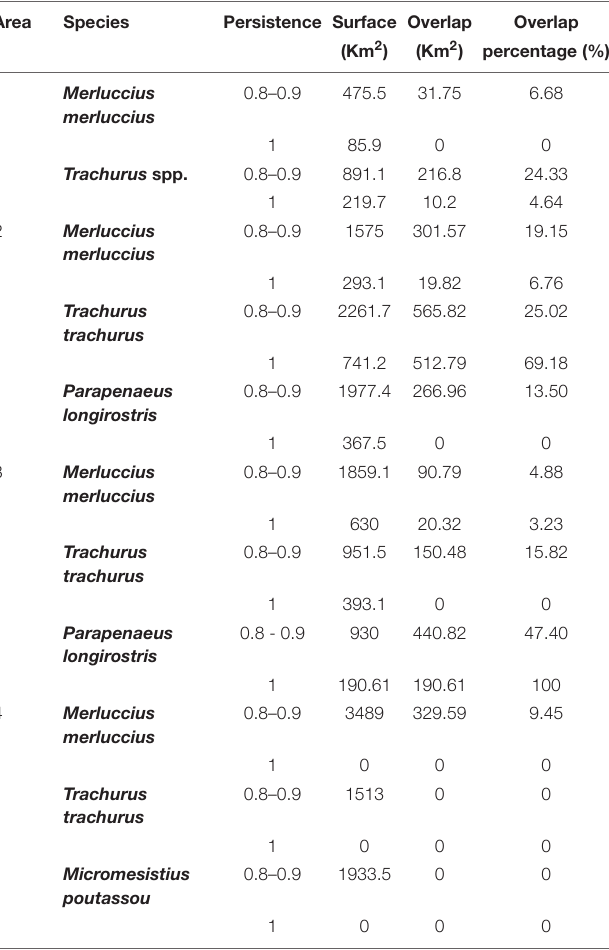
TABLE 2 | Spatial extension of persistence index (PI) expressed as Km 2 (Surface), and their overlap with persistence areas of fishing effort expressed as Km 2